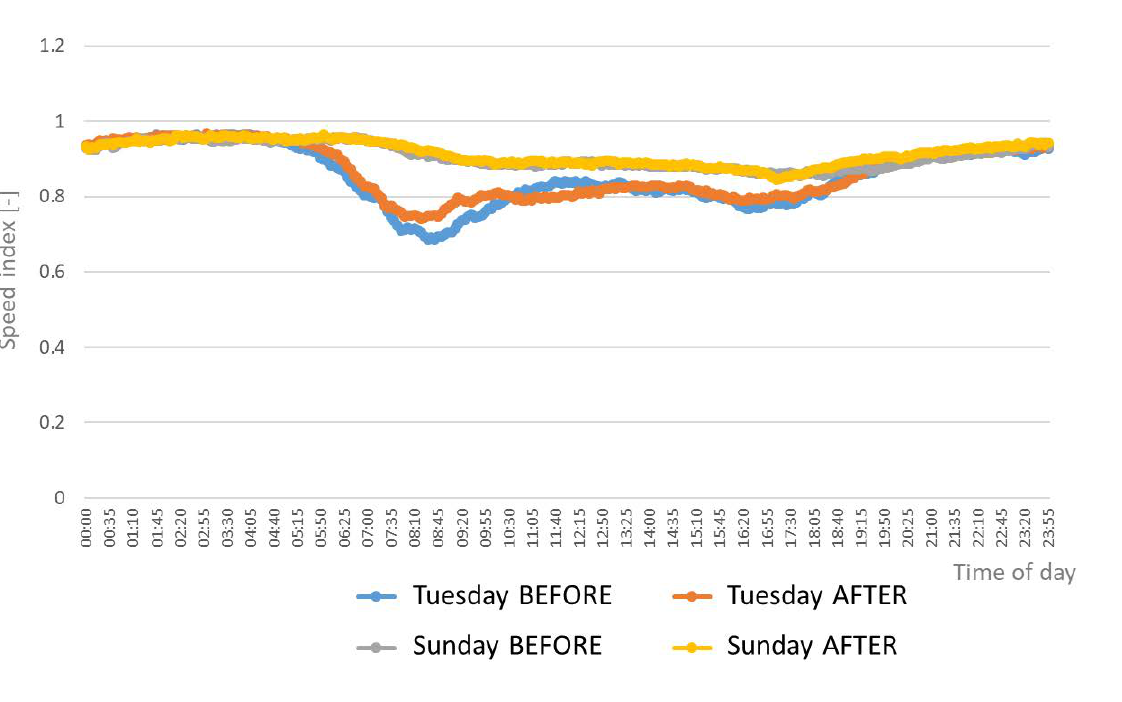
Figure 14. The average speed index over all sensors during the measurement